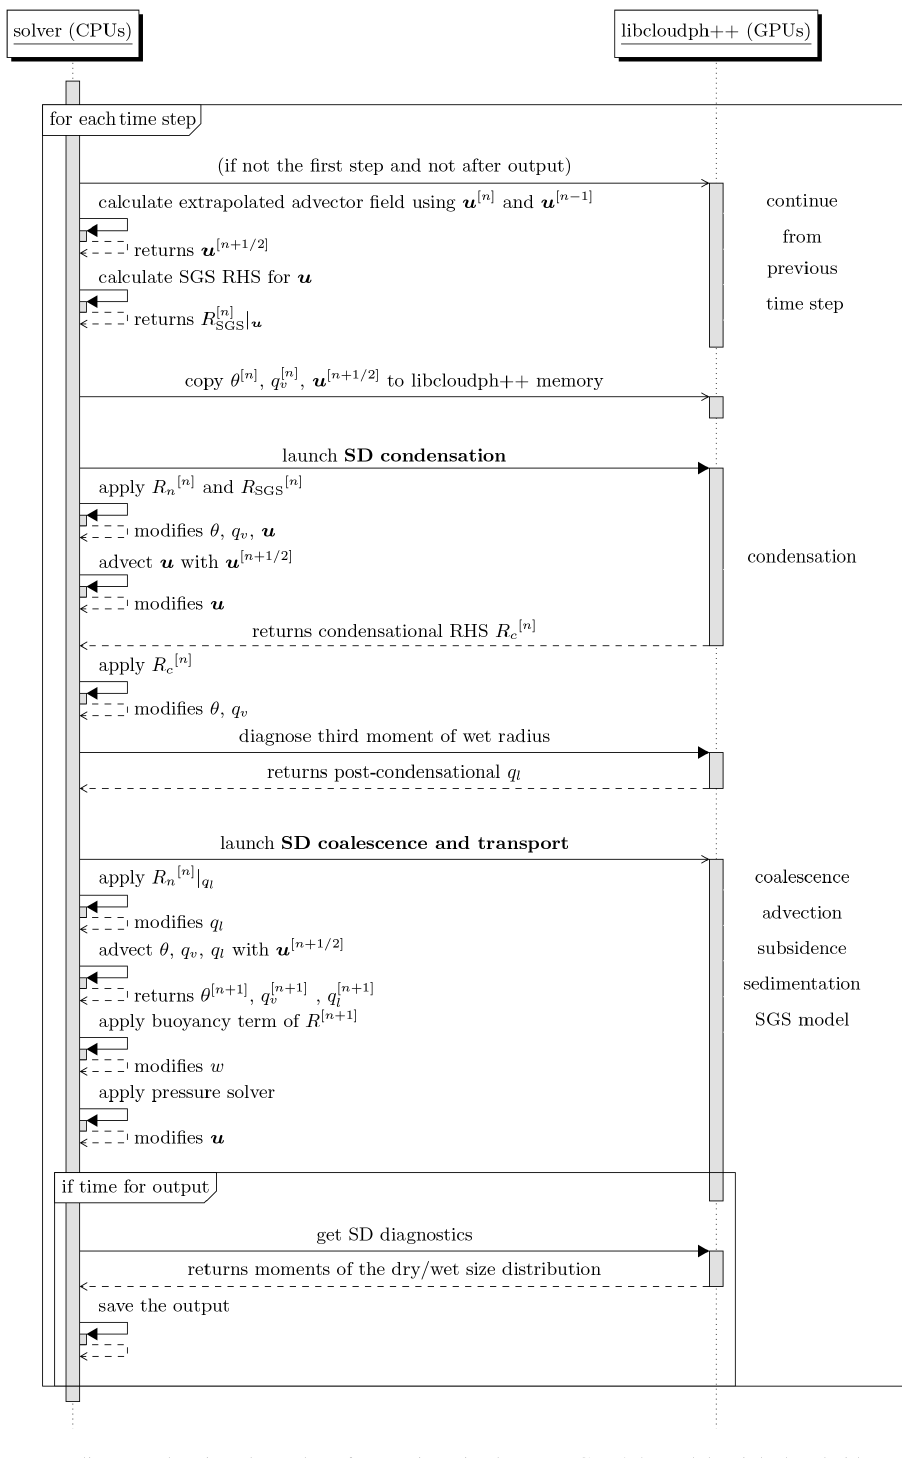
https://doi.org/10.5194/gmd-15-4489-2022 Geosci. Model Dev., 15, 4489–4501,